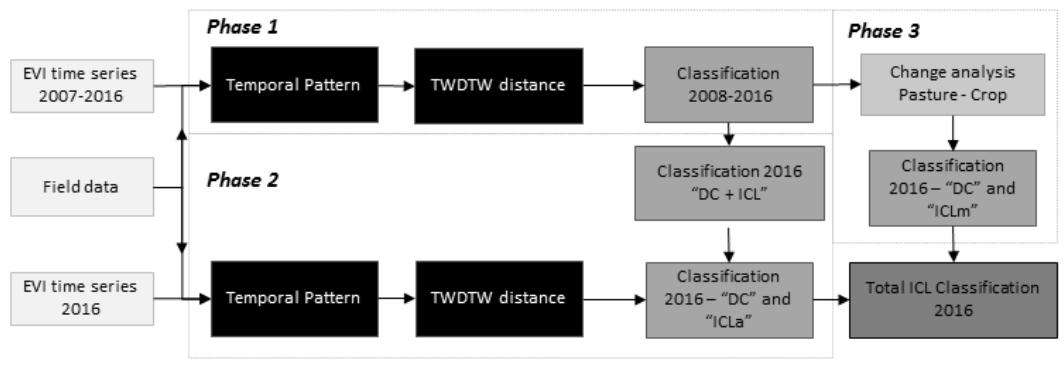
Figure 3. The flowchart of the proposed method for mapping integrated crop-livestock systems. Note: ICL, integrated crop-livestock.